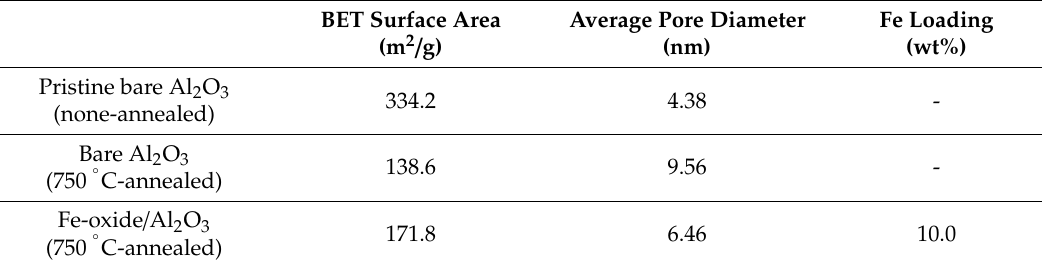
Figure 2. Barrett-Joyner-Halenda (BJH) pore size distributions of pristine Al 2 O 3 (none-annealed), bare Al 2 O 3 (750 °C-annealed), and Fe-oxide/Al 2 O 3 (750 °C-annealed) are shown. Table 1. BET specific surface areas and pore diameters of pristine bare Al 2 O 3 (none-annealed), bare Al 2 O 3 (750 °C-anneaeld), and Fe-oxide/Al 2 O 3 (750 °C-annealed) are summarized with the amount of Fe-loading of Fe-oxide/Al 2 O 3 (750 °C-annealed) sample determined by inductively coupled plasma optical emission spectroscopy (ICP-OES).